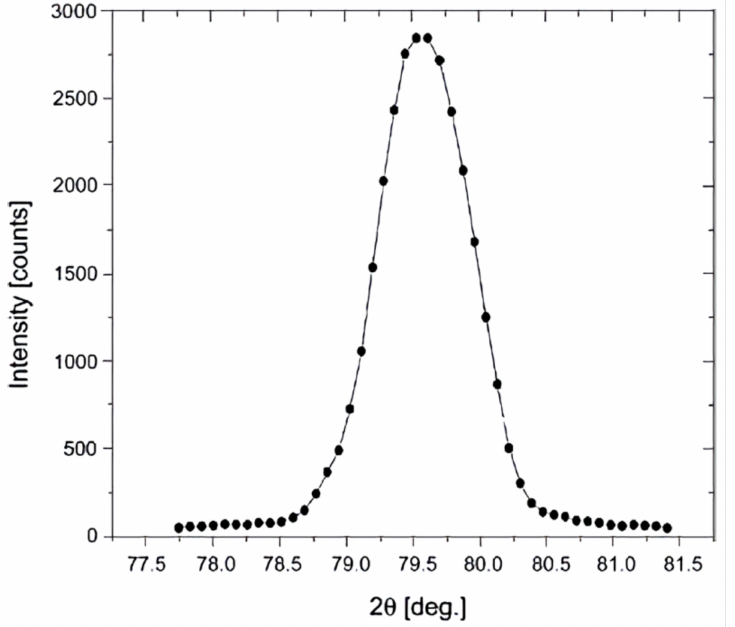
Figure 7. Neutron peak profile. Reproduced from [102] with permission from